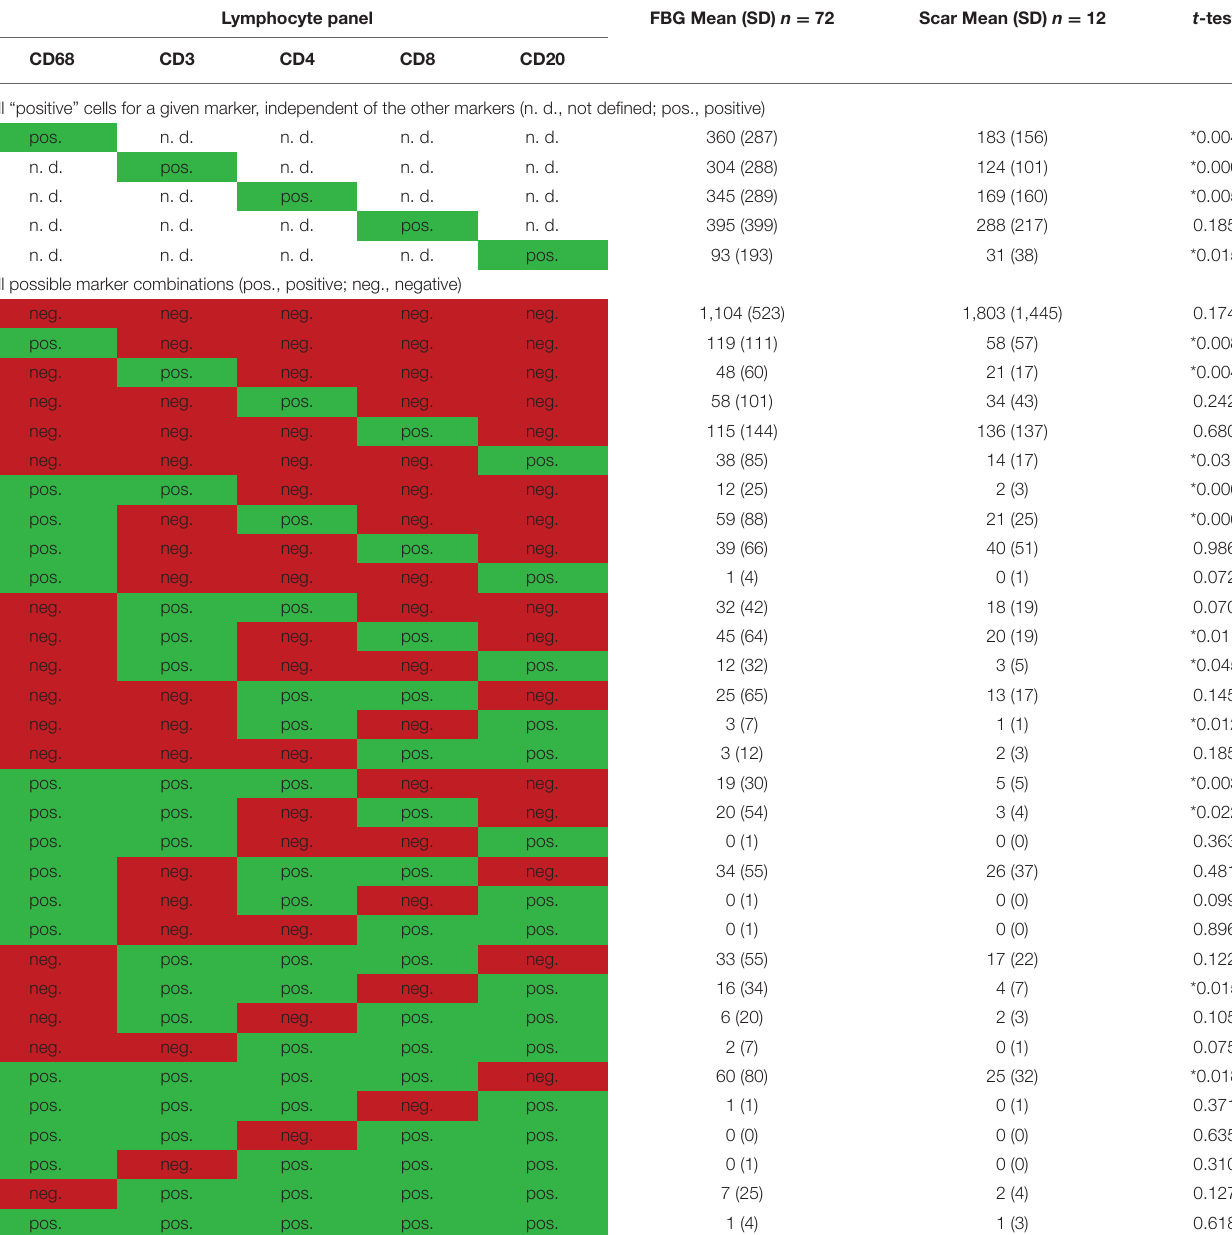
TABLE 4 | Comparison of cells located in the FBG and in the scar tissue by means of the lymphocyte panel. Lymphocyte